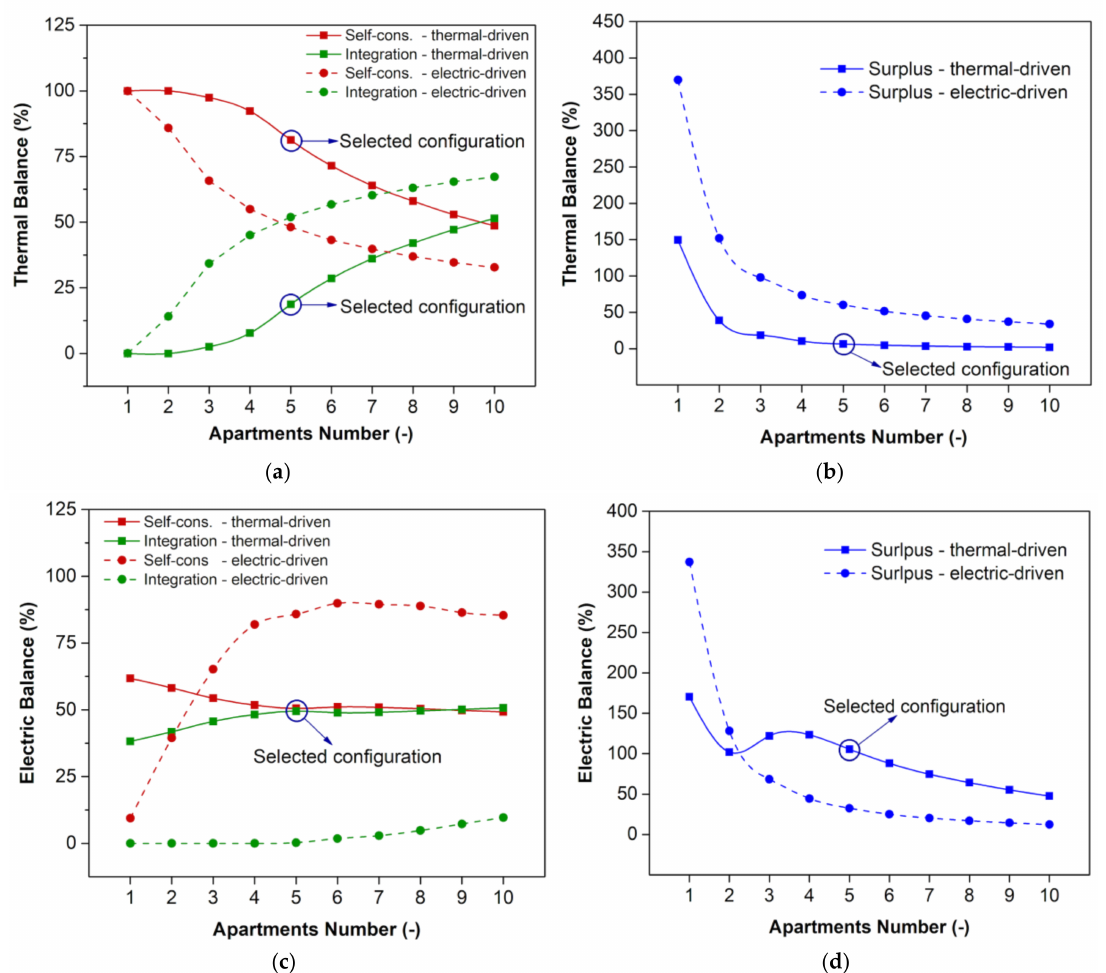
Figure 12. Comparison between thermal- and electric-driven strategies: ( a ) thermal self-consumption and integration; ( b ) thermal surplus; ( c ) electric self-consumption and integration; ( d ) electric